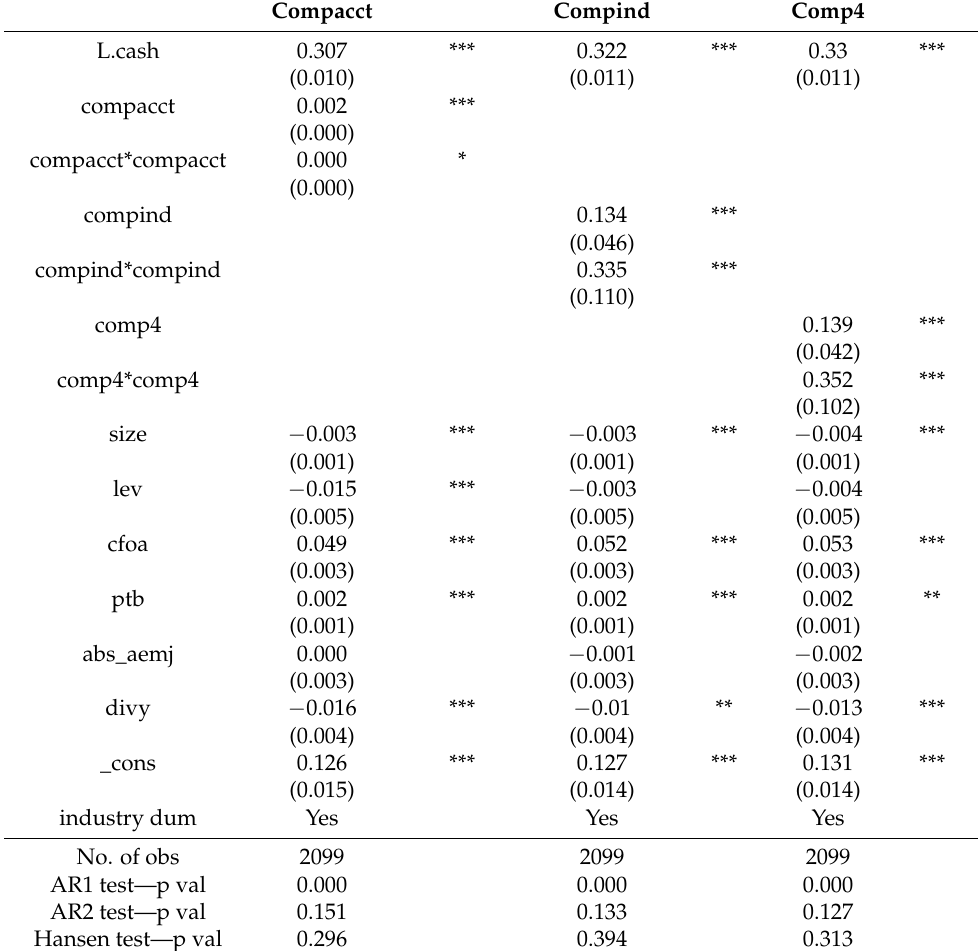
Table 4. Non-linear impact of comparability on cash